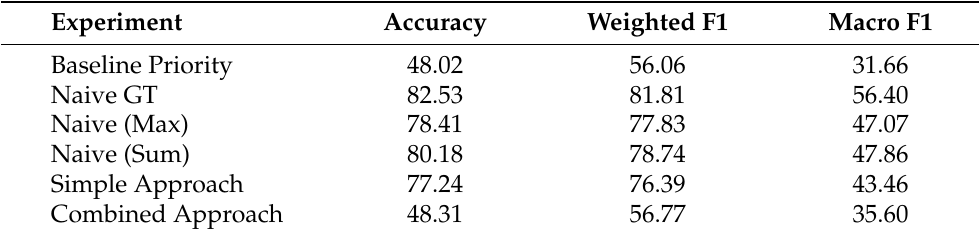
Table 11. Global metrics score of test set 1 for final priority level prediction (in %).